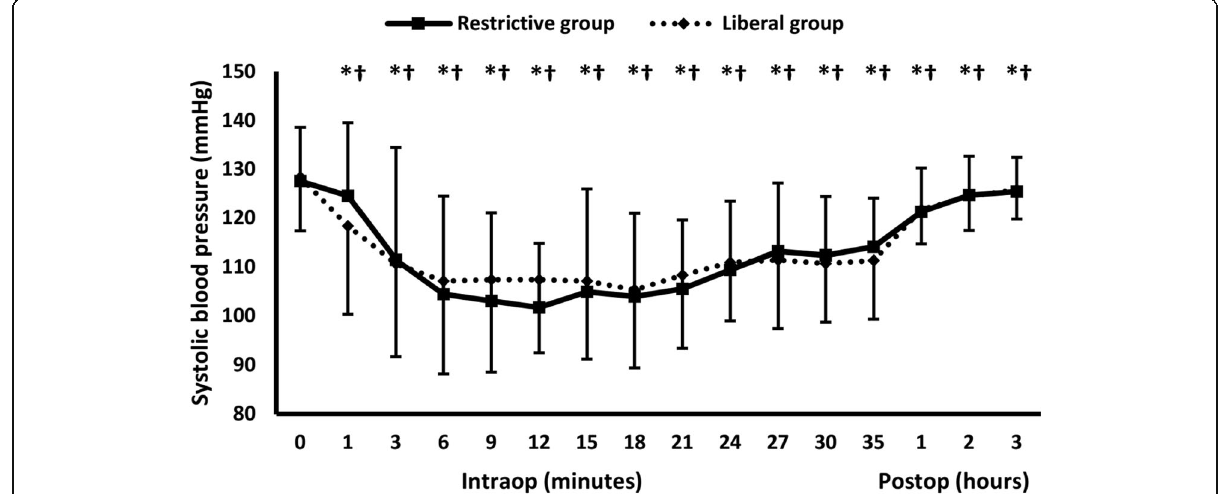
Fig. 2 Systolic blood pressure. * denotes statistical significance compared to the baseline reading within restrictive group, † denotes statistical significance compared to the baseline reading within liberal group. Intraop.: intraoperative, postop.: